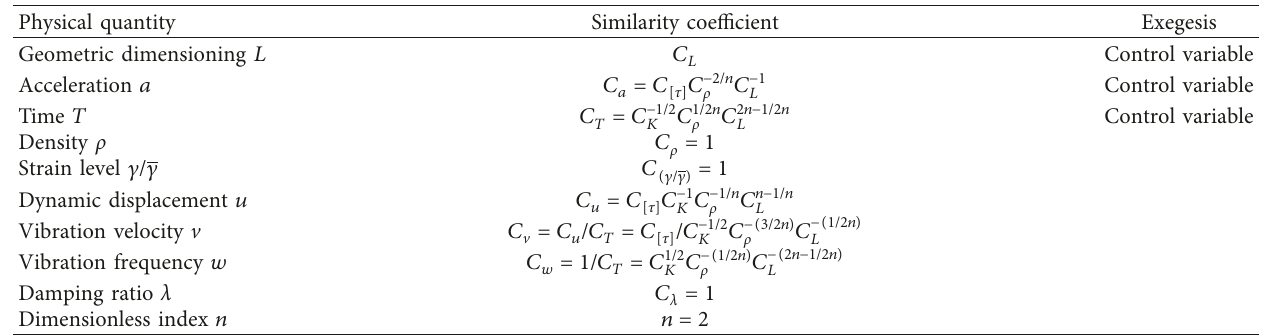
Figure 22: Test model of the slope. (a) Geometric model. (b) Test model. (c) Rainer. Table 13: Similarity coefficient between our test model and the actual projects.